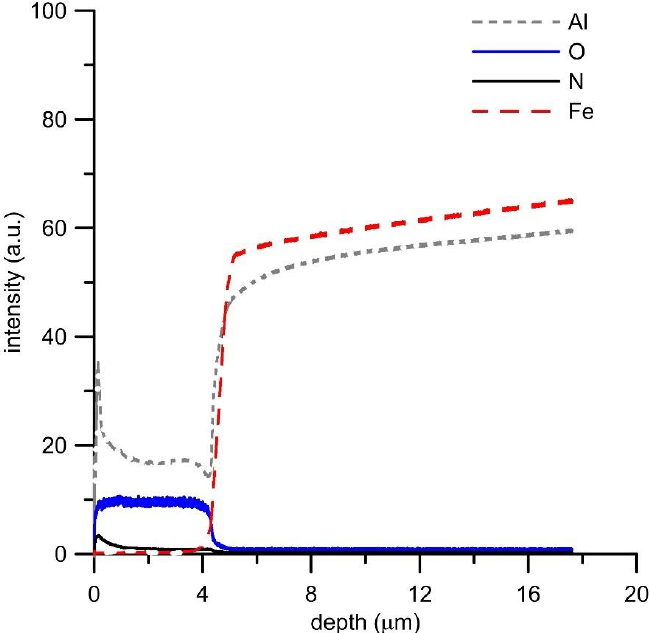
Figure 6 GDOES depth profile of oxidized FeAl32 alloy. Figure 6. GDOES depth profile of oxidized FeAl32